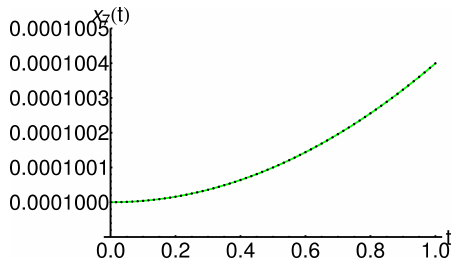
Fig. 7. Comparison between the approximate solutions ¯ x 7 given by Eq. (34) and the corresponding numerical